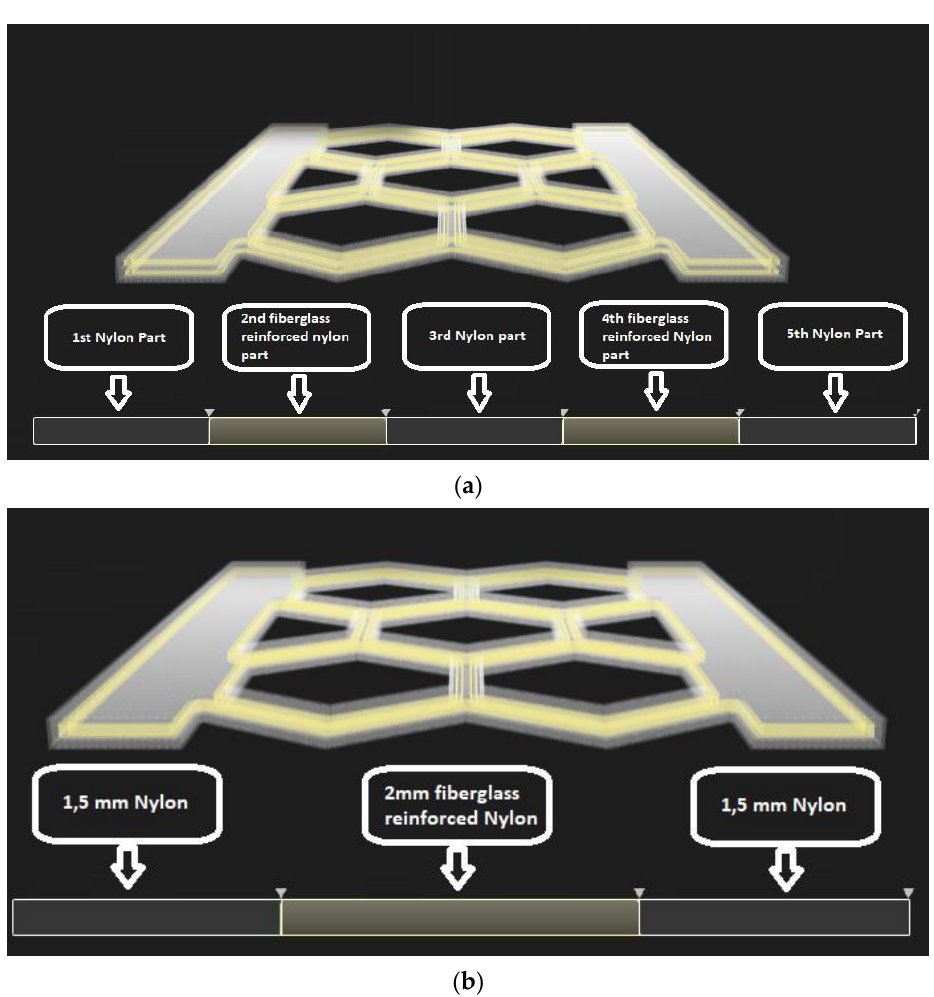
Figure 3. ( a ) 3D view of the fiberglass reinforced honeycomb structure (reinforcement in positions 2–4), ( b ) central fiberglass-reinforced honeycomb structure.